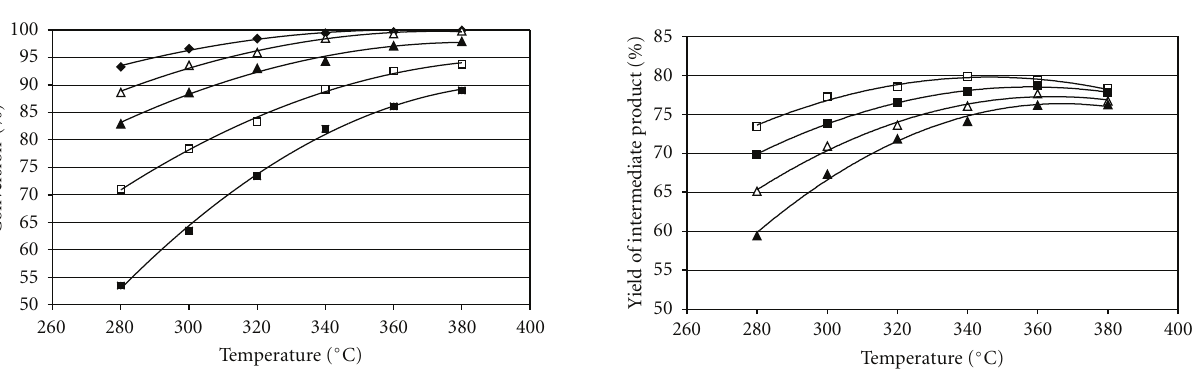
-20 bar, Δ -40 bar, (cid:3)